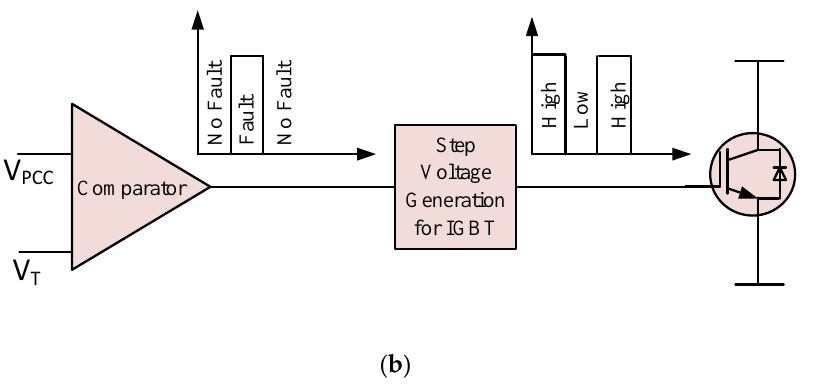
Figure 1. Bridge type fault current limiter ( a ) configuration ( b ) control strategy.